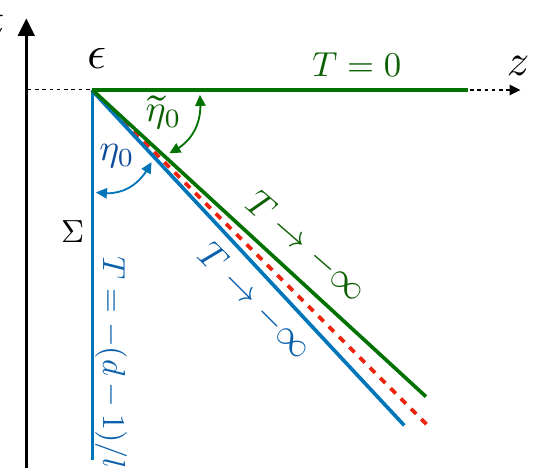
Figure 5 . Solutions of the maximization in Lorentzian AdS d +1 . Timelike half-planes (6.25), shown in blue, interpolate between the boundary at T = − ( d − 1) /l and null plane, dashed red, in the limit of T → −∞ . The counterpart of the inner angle (“rapidity”) η 0 given by (6.28) is shown in blue. Spacelike half planes (6.42), shown in green, interpolate between the null sheet for T → −∞ and the t = 0 slice at T = 0 . Their inner angle ˜ η 0 , given by (6.45), is shown in